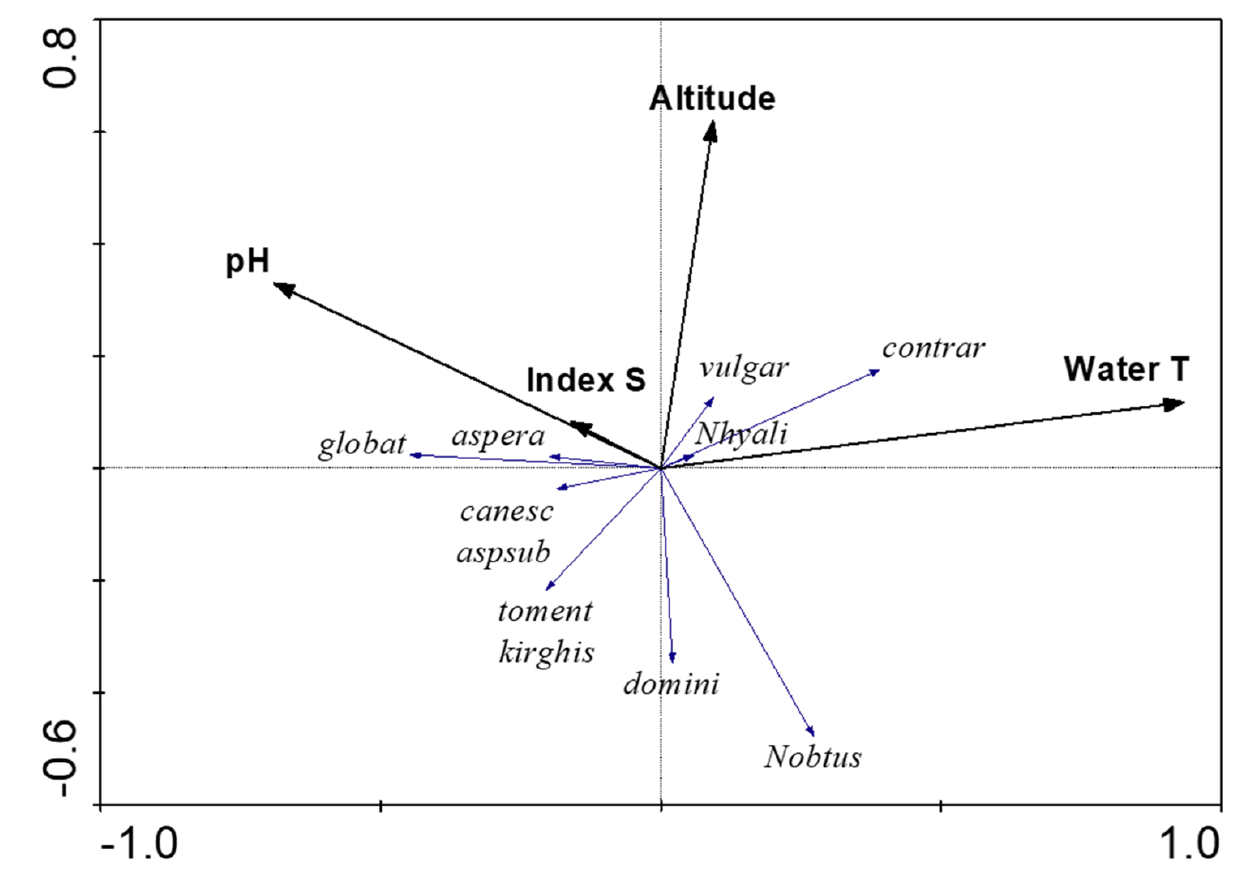
Figure 5. RDA plot of the relationships between environmental variables, Index of organic pollution S, altitude, pH, temperature, and species richness in the habitat community in studied sites of south and southeast Kazakhstan, 2019–2022. Monte Carlo test summary for 999 permutations: significance of first canonical axis: eigenvalue = 0.075; significance of all canonical axes: Trace = 0.177, p -value = 0.094.